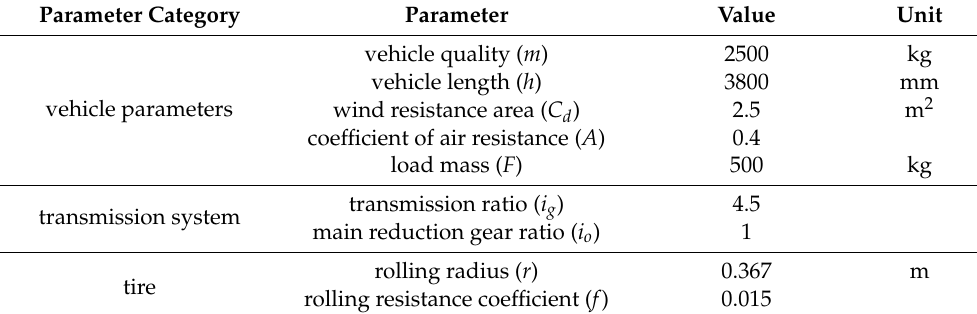
Table 3. Main performance